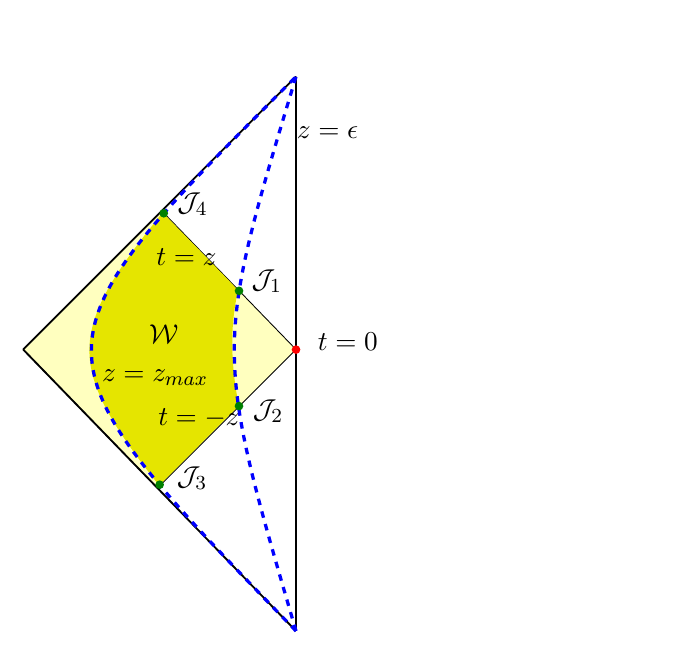
Figure 1 . WdW-patch for the t = 0 boundary slice in the Poincar(cid:19)e-patch. Technically, the WdW- patch would be the lightly shaded square region between the lightfronts t = (cid:6) z and the Poincar(cid:19)e- horizon. However, we introduce the (cid:12)eld-theory UV cuto(cid:11) z = (cid:15) and the IR cuto(cid:11) z = z max near the Poincar(cid:19)e-horizon, shown as dashed (blue) lines. Hence, the integration-domain W for the action proposal, which we will still refer to as WdW-patch, is the darkly shaded region. We also mark the locations of the four spacelike joints J 1 - J 4